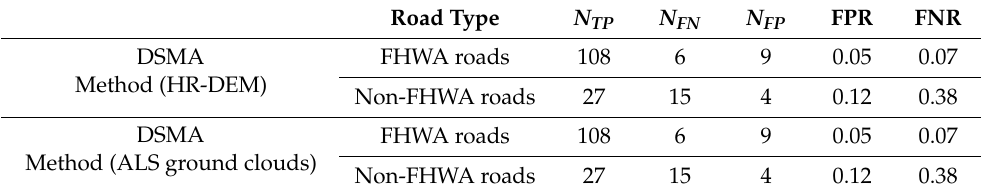
Table 2. Commission and emission error rates originating from the culvert-modified DEM obtained using DSMA-based mapped DSs, whereas the input source datasets were the HR-DEM and original ALS point